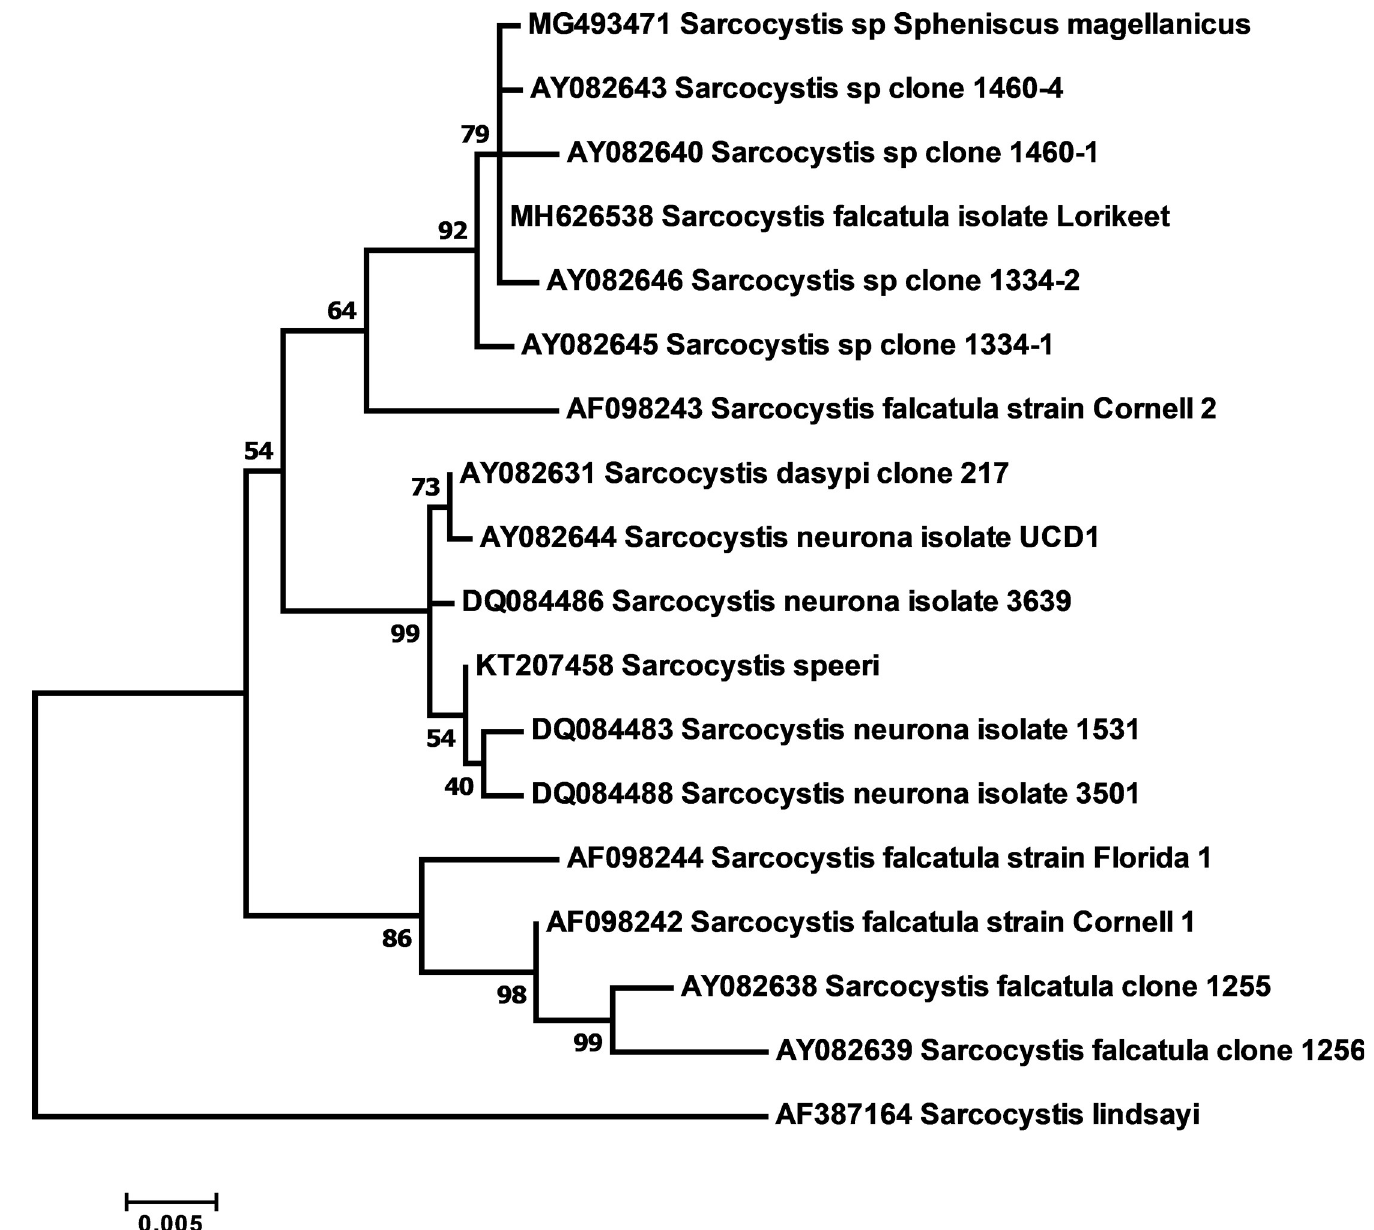
Fig 2. Phylogenetic analysis of Sarcocystidae related to Sarcocystis spp. of Magellanic penguins ( Spheniscus magellanicus ) based on internal transcribed spacer 1 (ITS1). The evolutionary history was inferred by using the maximum likelihood method based on the Hasegawa-Kishino-Yano nucleotide substitution model.